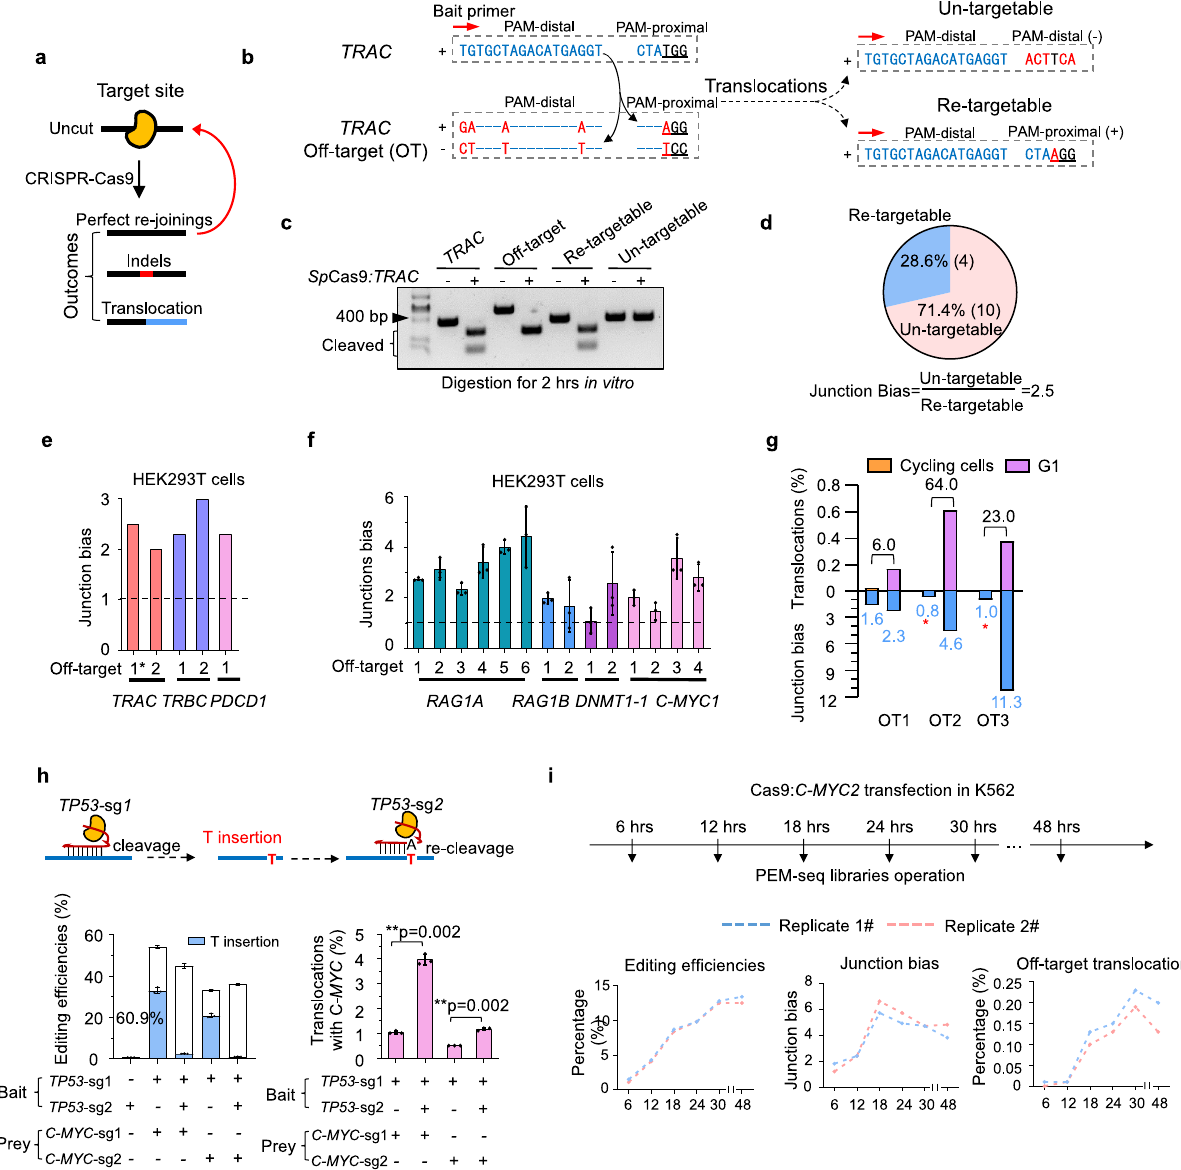
Fig. 2 Enhancing junction bias by repeated cleavage of CRISPR-Cas9. a Schematics for editing outcomes and repeated cleavage of CRISPR-Cas9. The perfect rejoinings and some mildly mutated repaired products can be repeatedly cleaved by CRISPR-Cas9. b DNA sequences of potential translocation products between TRAC on- and off-target sites. Red letters indicate mismatches between TRAC on- and off-target sites. By performing PEM-seq using the indicated bait primer (red arrow) at the TRAC PAM-distal end, two types of translocation products may form: “ re-targetable ” and “ un-targetable ” . “ + ” or “ − ” indicates the derivation for the TRAC off-target strand. c In vitro digestion for TRAC on-target site, off-target site, and translocation products shown in panel b by Sp Cas9: TRAC . The black arrow indicates the 400 bp DNA marker. Cleaved DNA is indicated by the black bracket. d Percentages for “ re- targetable ” and “ un-targetable ” translocation products in human T cells cloned from the TRAC on-target site by PEM-seq. Junction numbers are labeled in the brackets. e Junction bias at the off-targets of TRAC, TRBC , and PDCD1 in HEK293T cells detected by PEM-seq. The dashed line indicates the ratio = 1, N = 1. f Junction bias at the off-targets of indicated loci in HEK293T cells detected by PEM-seq. Mean± SD from three biological replicates. The dashed line indicates the ratio = 1. The numbers on the x- axis indicate the off-target order from strong to weak. g Percentage for off-target translocations and junction bias at three off-target sites (OT1 to OT3) from the HBA1 locus in K562 cells. Fold changes and junction bias are marked on the bar. Off-target sites with too few junctions are highlighted by * in red, N = 1 for three off-targets. h Schematics for two rounds of cleavage at TP 53 locus in HEK293T cells using Cas9: TP53 -sg1 and Cas9: TP53 -sg2. Editing ef fi ciency and percentage of translocations for indicated treatments were detected by PEM-seq. The blue bar indicates the editing products with a T insertion. Mean± SD from three replicates. Two-tailed t -test, * p < 0.05 and ** p < 0.01. Note that 60.9% is normalized to total editing events. i Editing ef fi ciency, junction bias at off-targets, and percentages for off-target translocations at C-MYC2 locus at indicated time points in K562 cells detected by PEM-seq, N = 2. Source data are provided as a Source Data fi le.